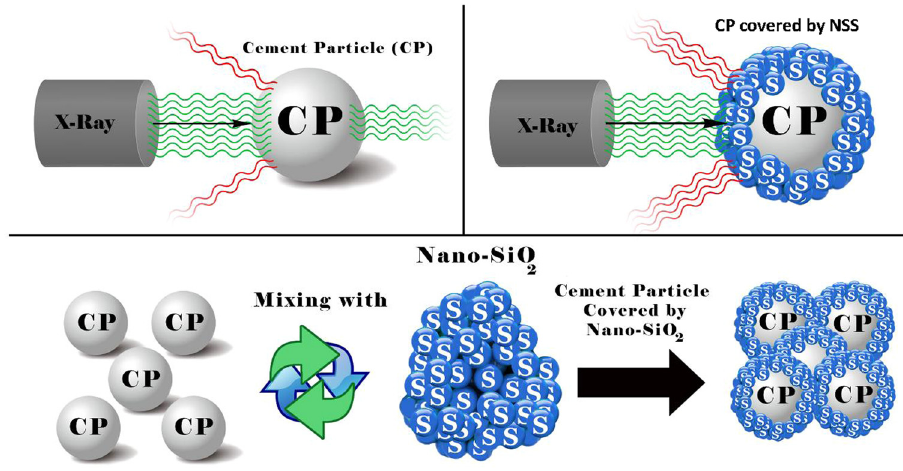
Figure 14: The role of NSS in enhancing the shielding capability of the produced